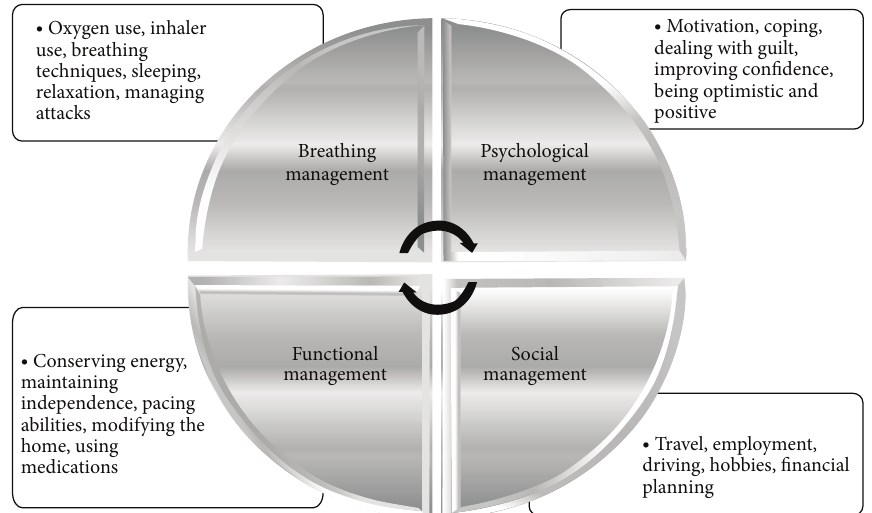
Figure 2: Four-way interactive structure for self-management.